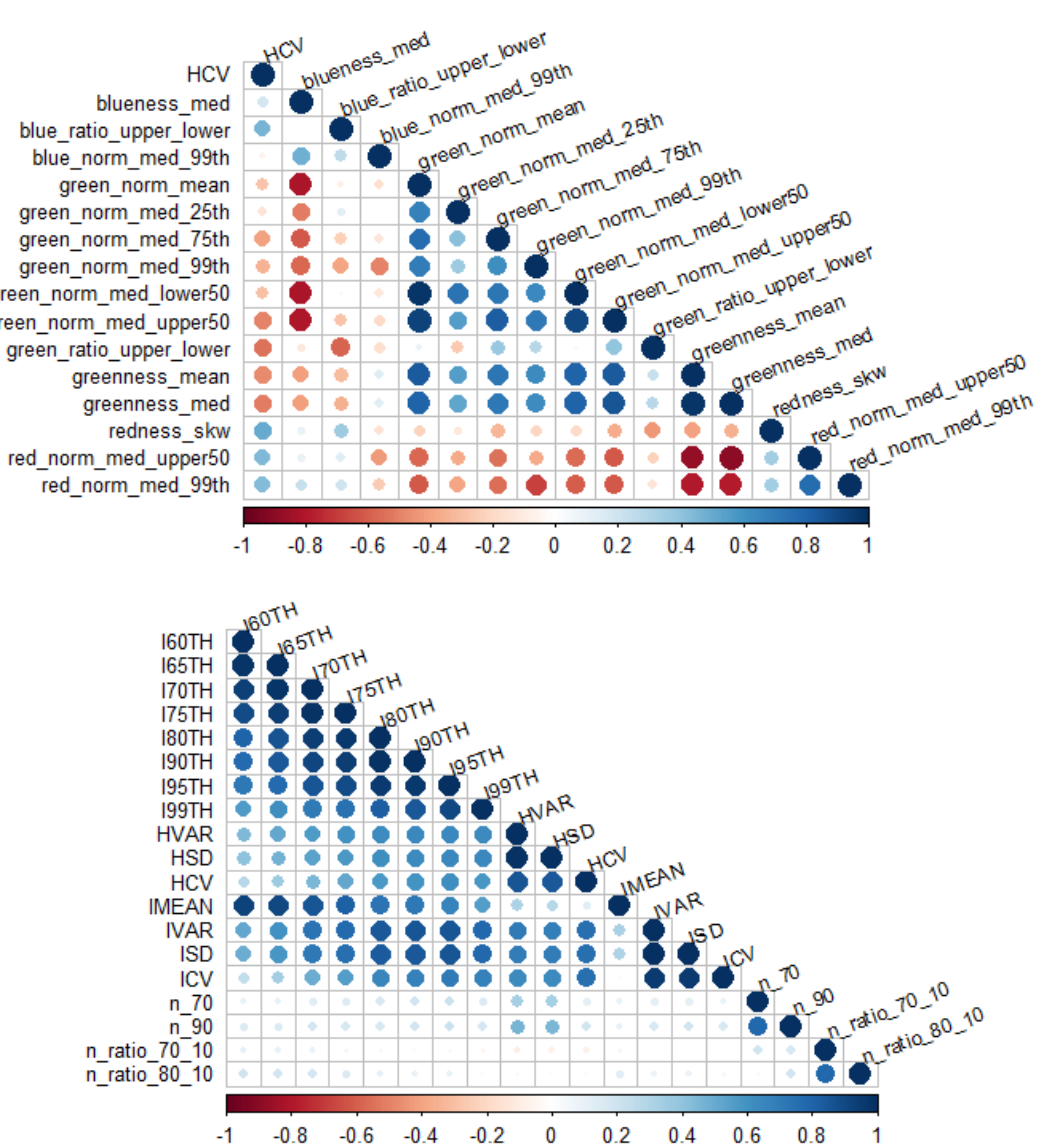
Figure 5. Correlations between most important variables for UAV ( above ) and G-LiHT ( below ) structural data. Blue color indicates positive correlation, red color indicates negative. Circle size and color intensity indicate degree and direction of correlation.